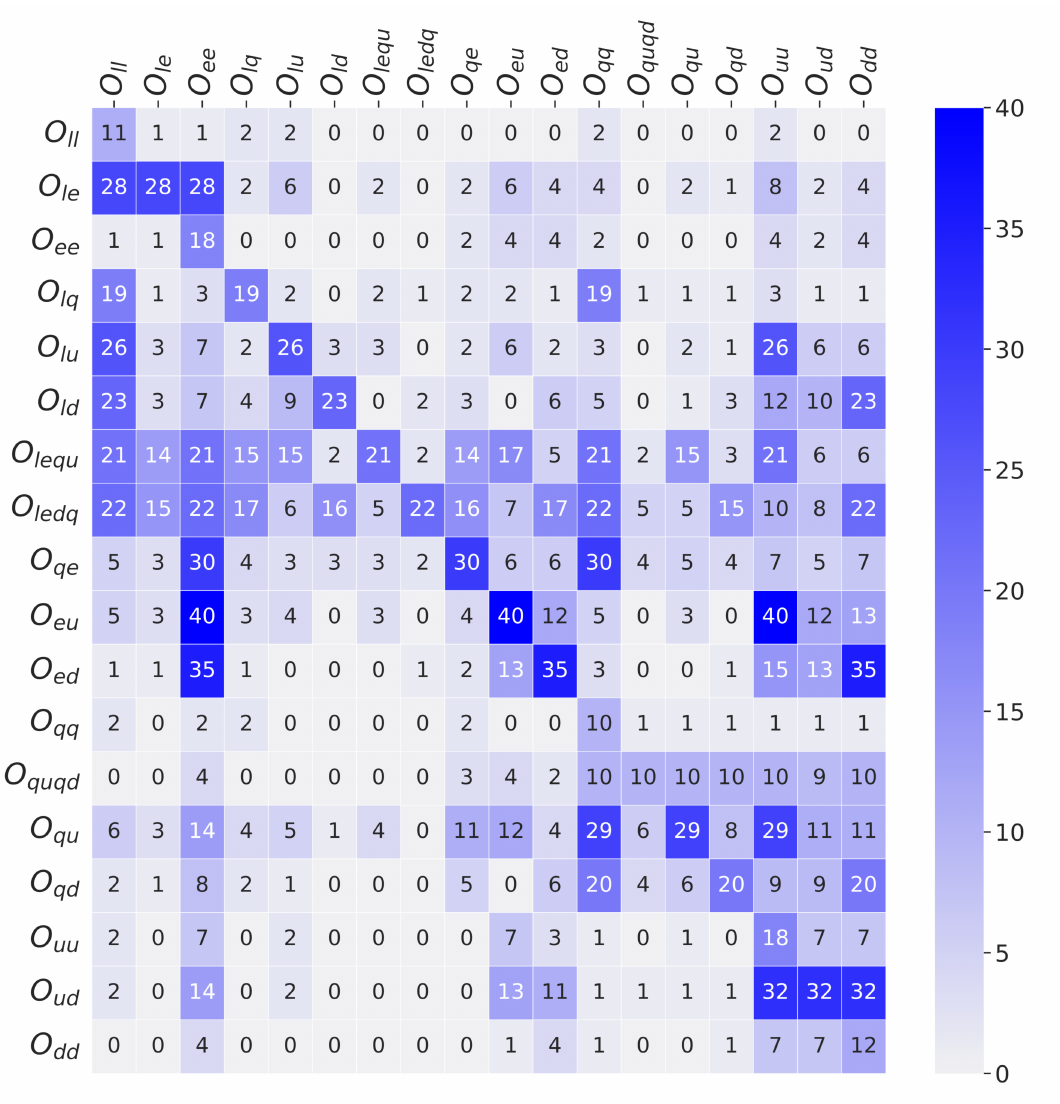
Figure 6. Operator overlap for maxSU 3 = 3 , maxSU 2 = 2 and maxY = 4